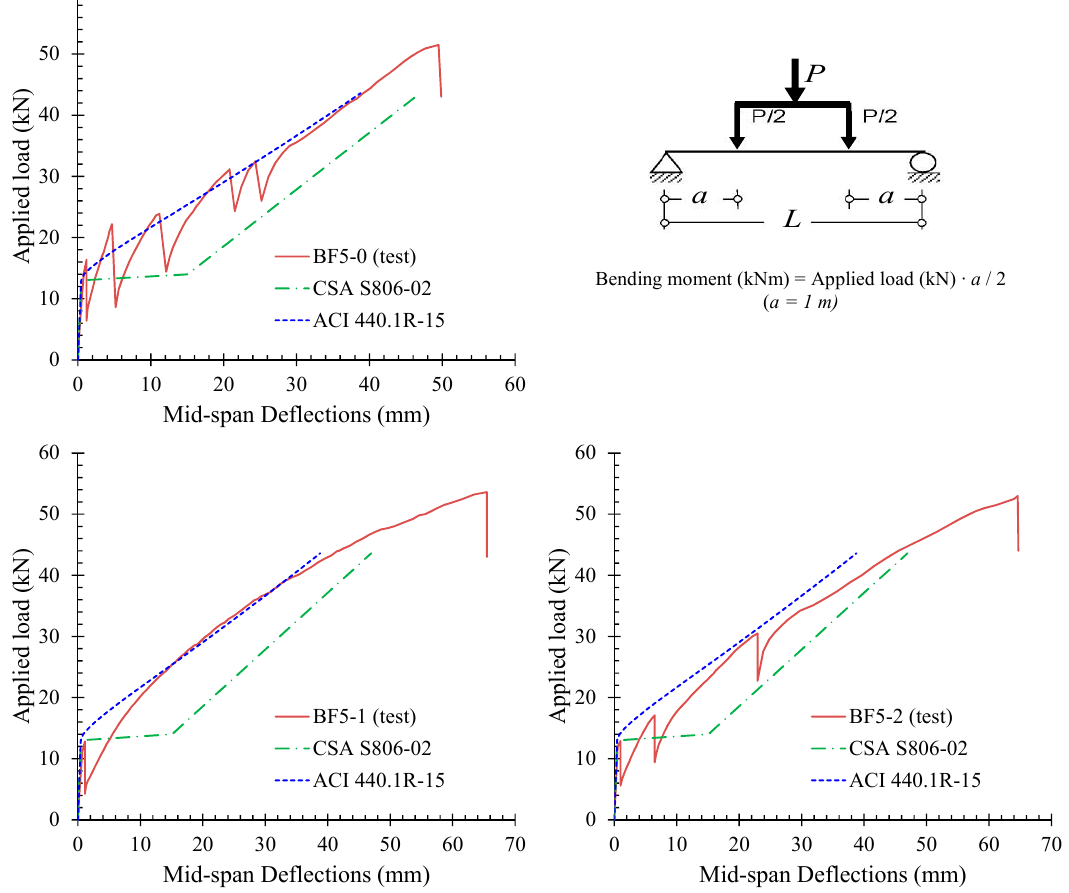
Figure 11. Comparisons of the test results with the predictions according to ACI 440.1R-15 and to CSA S806-12 for beams BF5-0, BF5-1, and BF5-2. FRP reinforcement of series “BF5” beams: ρ f = 0.12%.